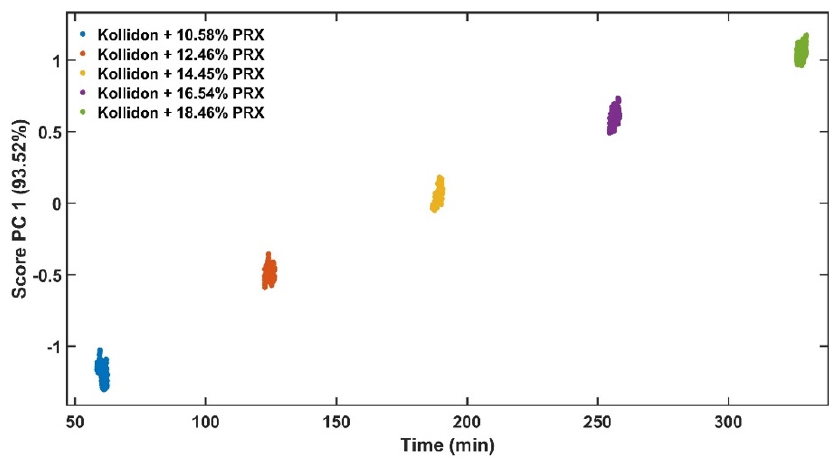
Figure 9. Score of PC1 vs. experiment time only in steady state.